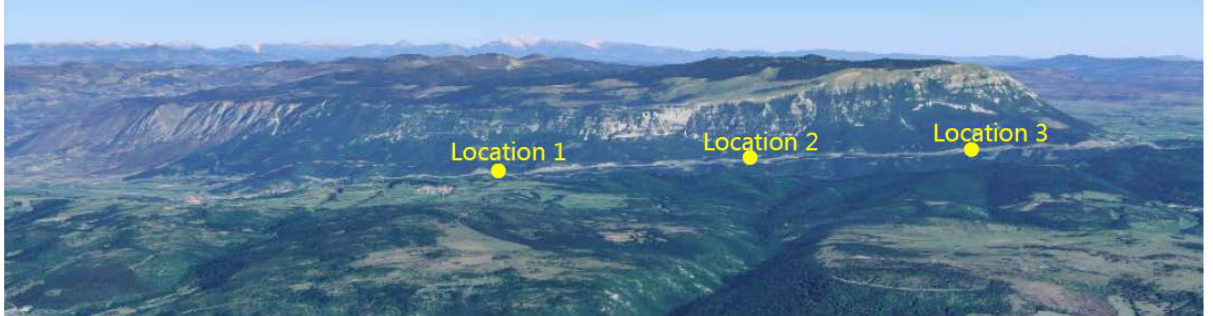
Figure 7. GIMS Pilot Area 1: the Vipava valley (Slovenia). The AR1 was installed in the Location 1